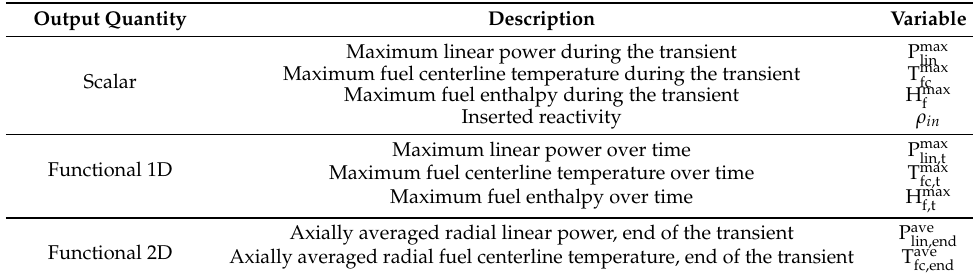
Table 6. Output quantities for transient calculations.